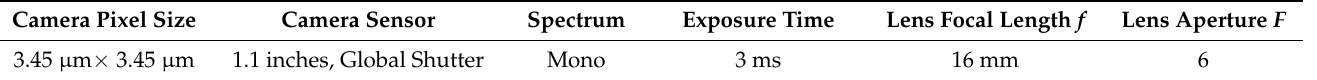
Figure 11. Physics experiment platform. Table 1. Camera and lens parameters table. Table 1. Camera and lens parameters table.